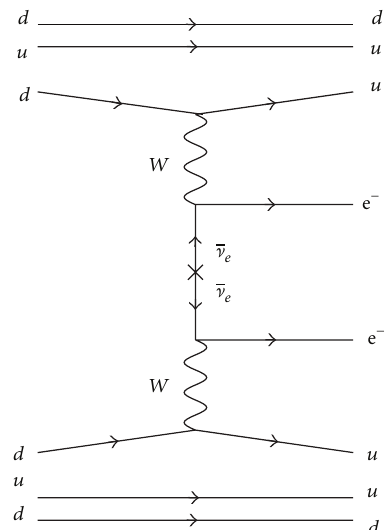
Figure1:Feynmandiagramfor 𝛽𝛽0 ] throughtheexchangeofalight Majorana